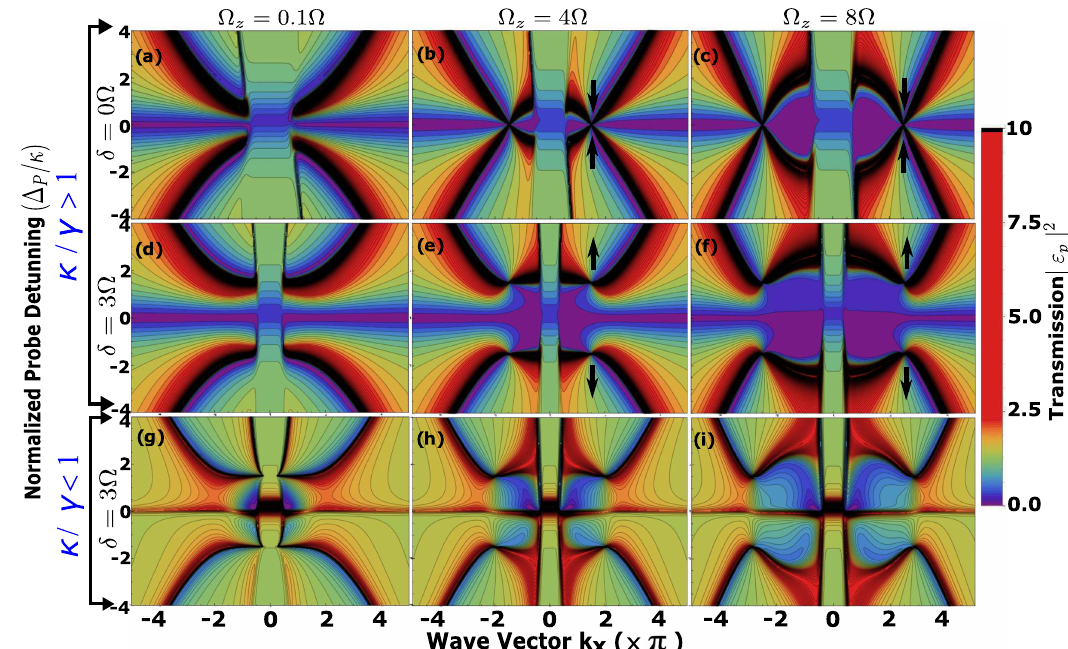
Fig. 3 Topological effects in probe transmission. The transmission amplitude jE p j 2 versus k x ( × π ) and Δ p / κ . The fi rst (( a ), ( d ) and ( g )), second (( b ), ( e ) and ( h )) and third (( c ), ( f ) and ( i )) columns illustrate the in fl uence of Ω z = 0.1 Ω , 4 Ω and 8 Ω , respectively, on the bulk modes. While the fi rst (( a ), ( b ) and ( c )), second (( d ), ( e ) and ( f )) and third (( g ), ( h ) and ( i )) rows accounts for δ = 0 Ω , 3 Ω and 3 Ω , respectively. The fi rst and second rows correspond to the lossy regime ( κ / γ > 1) while the third row is for gain regime ( κ / γ < 1). The strength of SC-coupling is α = 2 Ω in these results. Black arrows indicate the location of gapped and gapless transition in the bulk